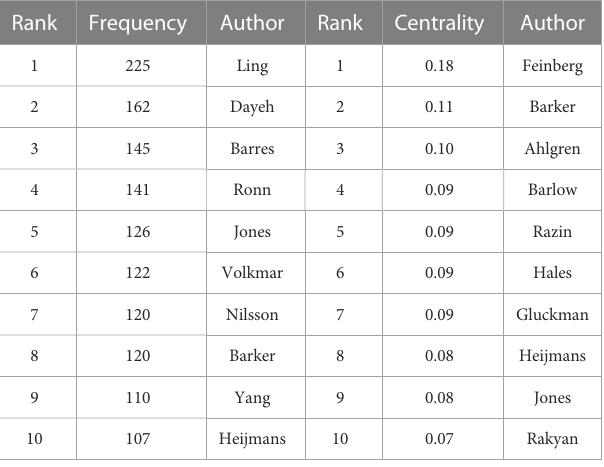
TABLE 2 Top 10 cited authors related to T2DM and DNA/RNA methylation modi fi cations.